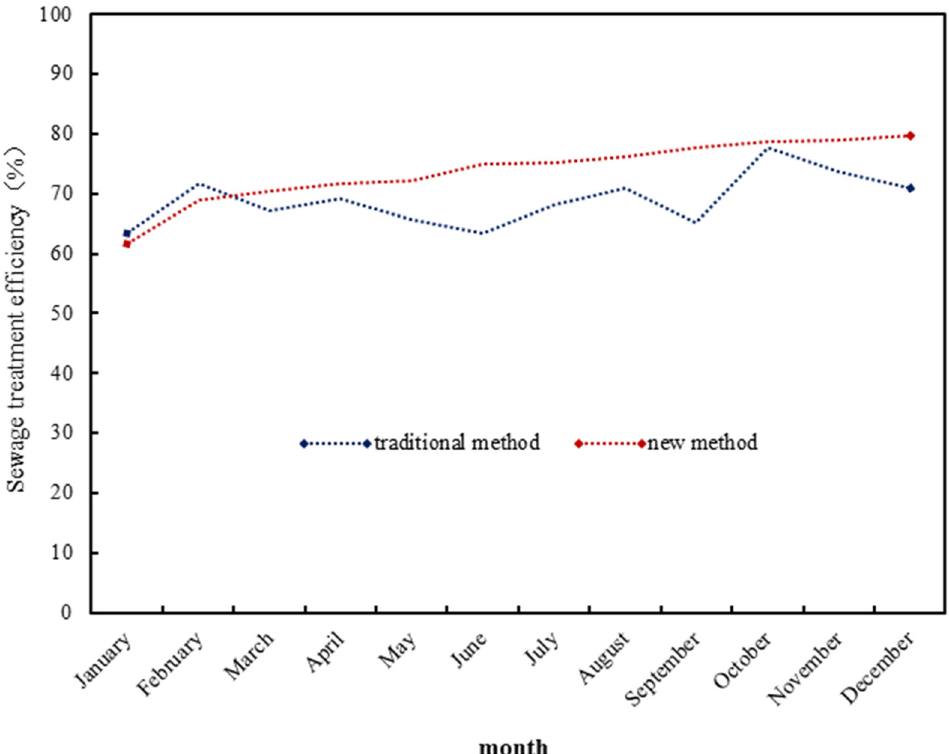
Figure 7. Efficiency of wastewater treatment using two methods within one year .